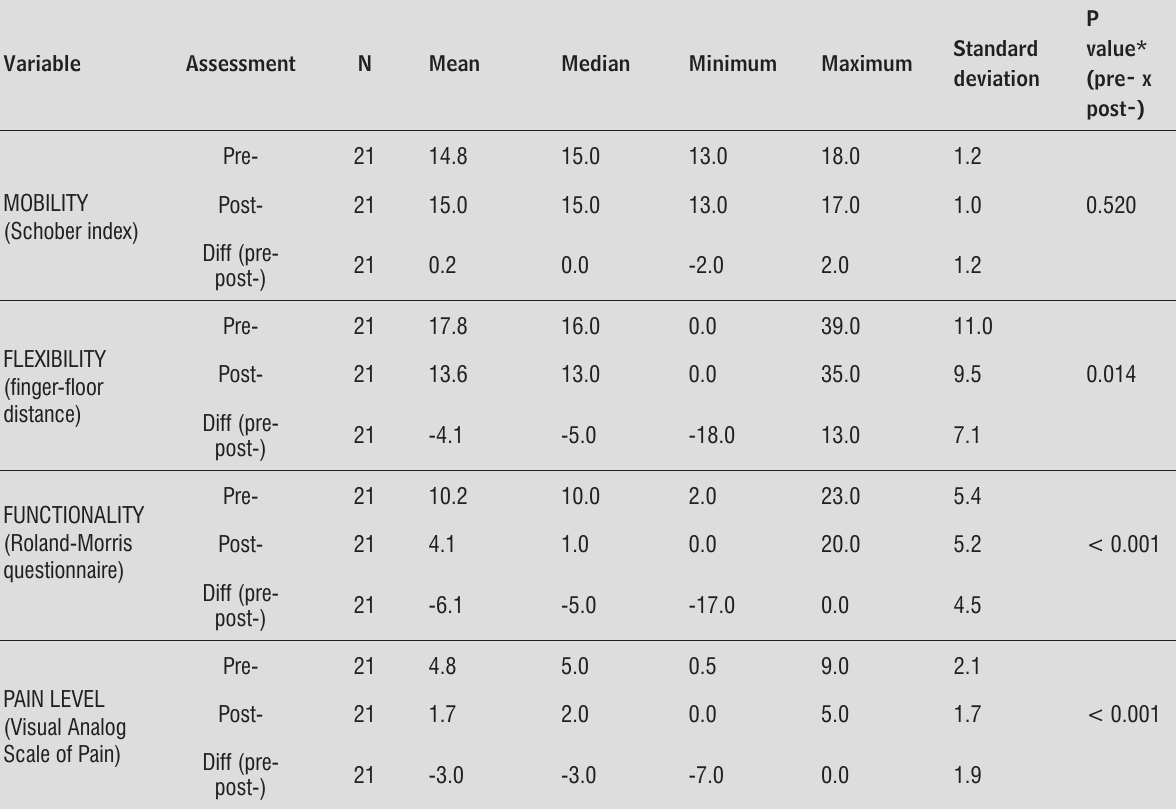
Table 2 - Descriptive statistics of the variables mobility, flexibility, functionality, and pain level, and the p values of statis- tical tests